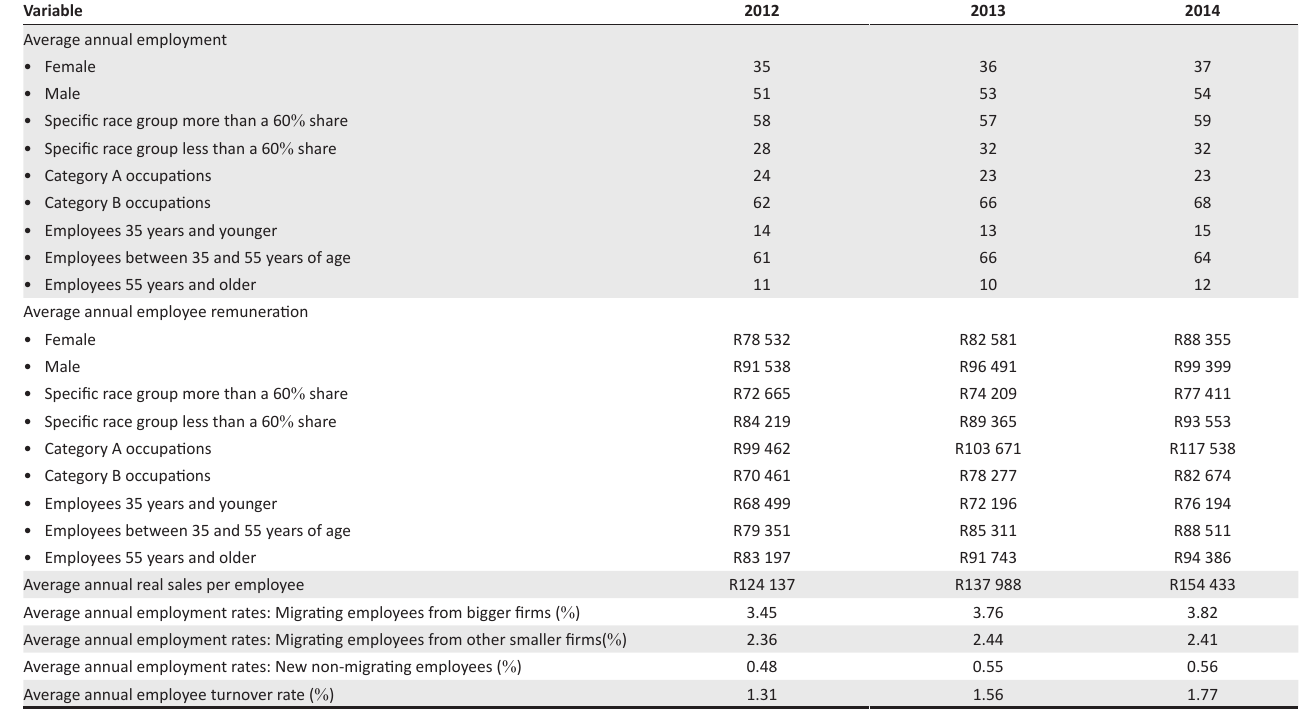
TABLE 1-A1: Summary